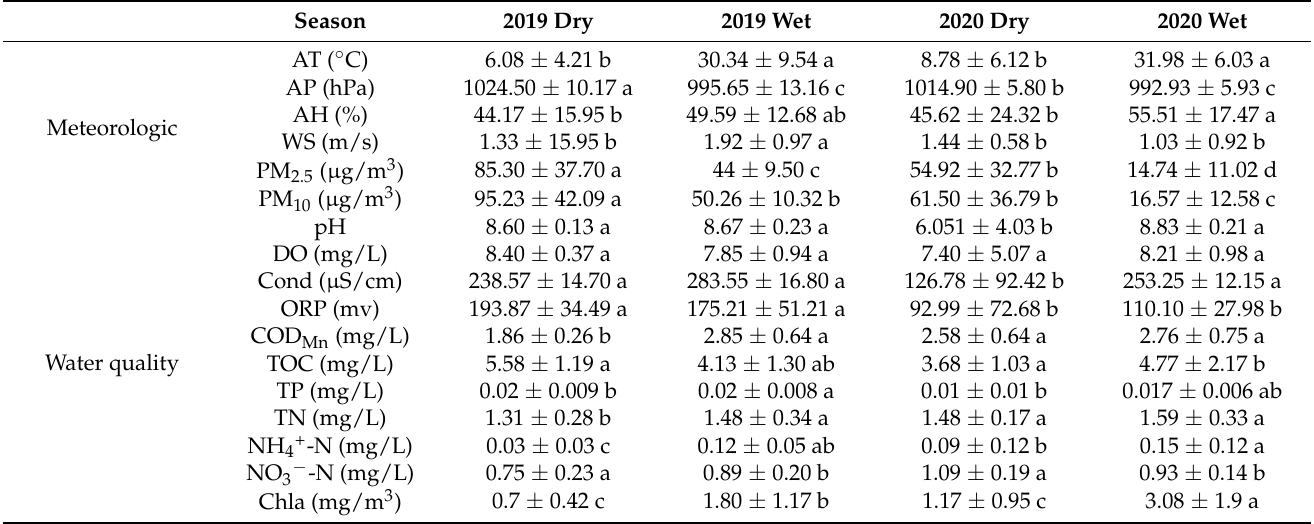
Table 3. Seasonal variations of meteorological factors and water quality factors.